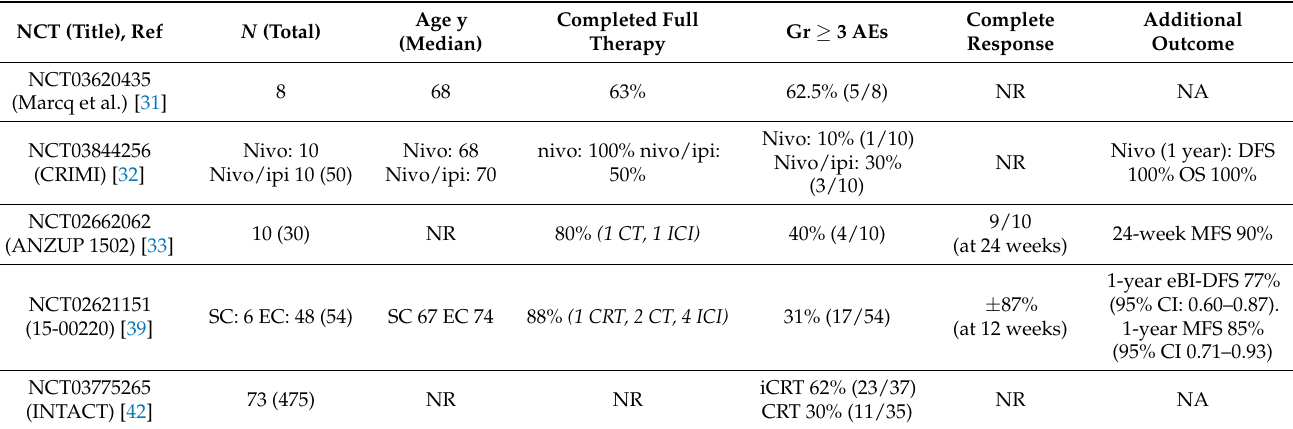
Table 2. Preliminary results of studies on ICI + CRT.